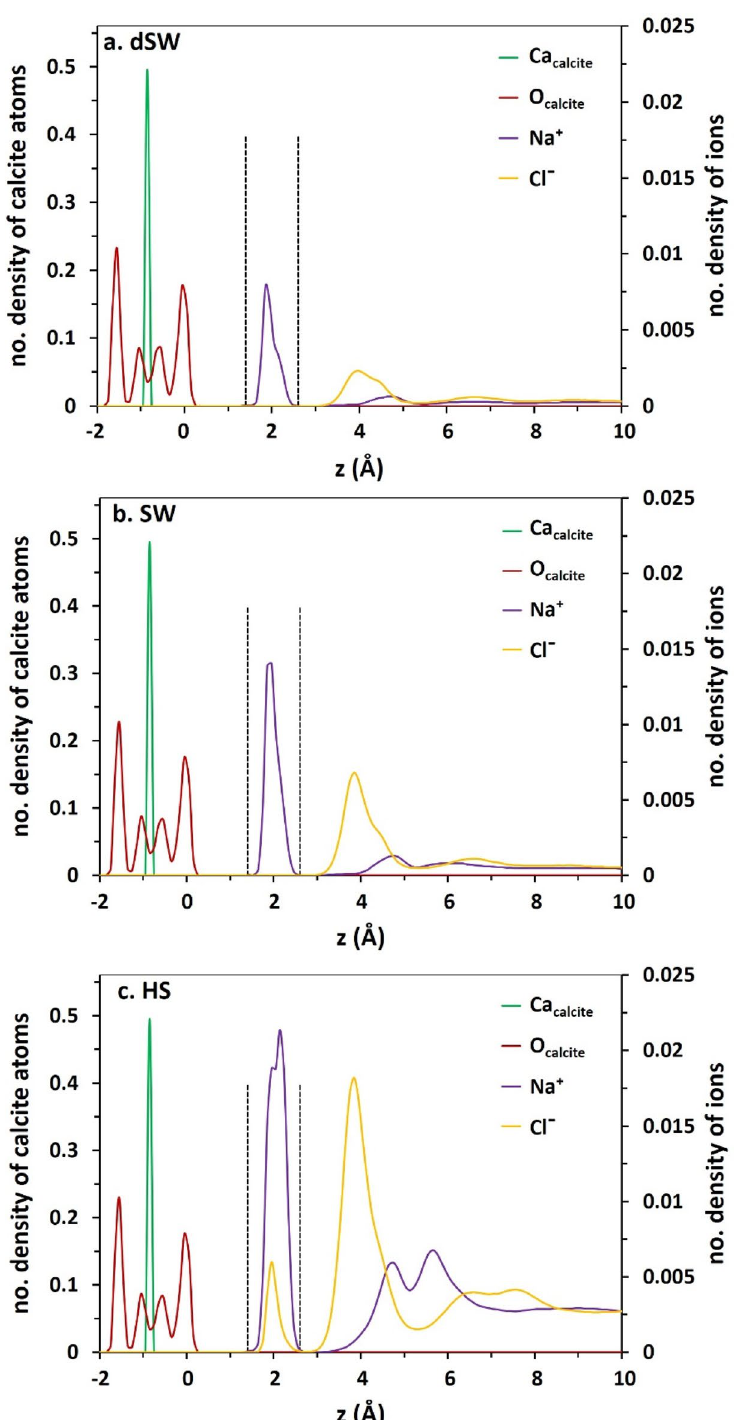
Figure 2. The density profile of ions in brines with respect to Ca and O-atoms of calcite topmost layer. The dashed lines highlight the position of water density maxima over